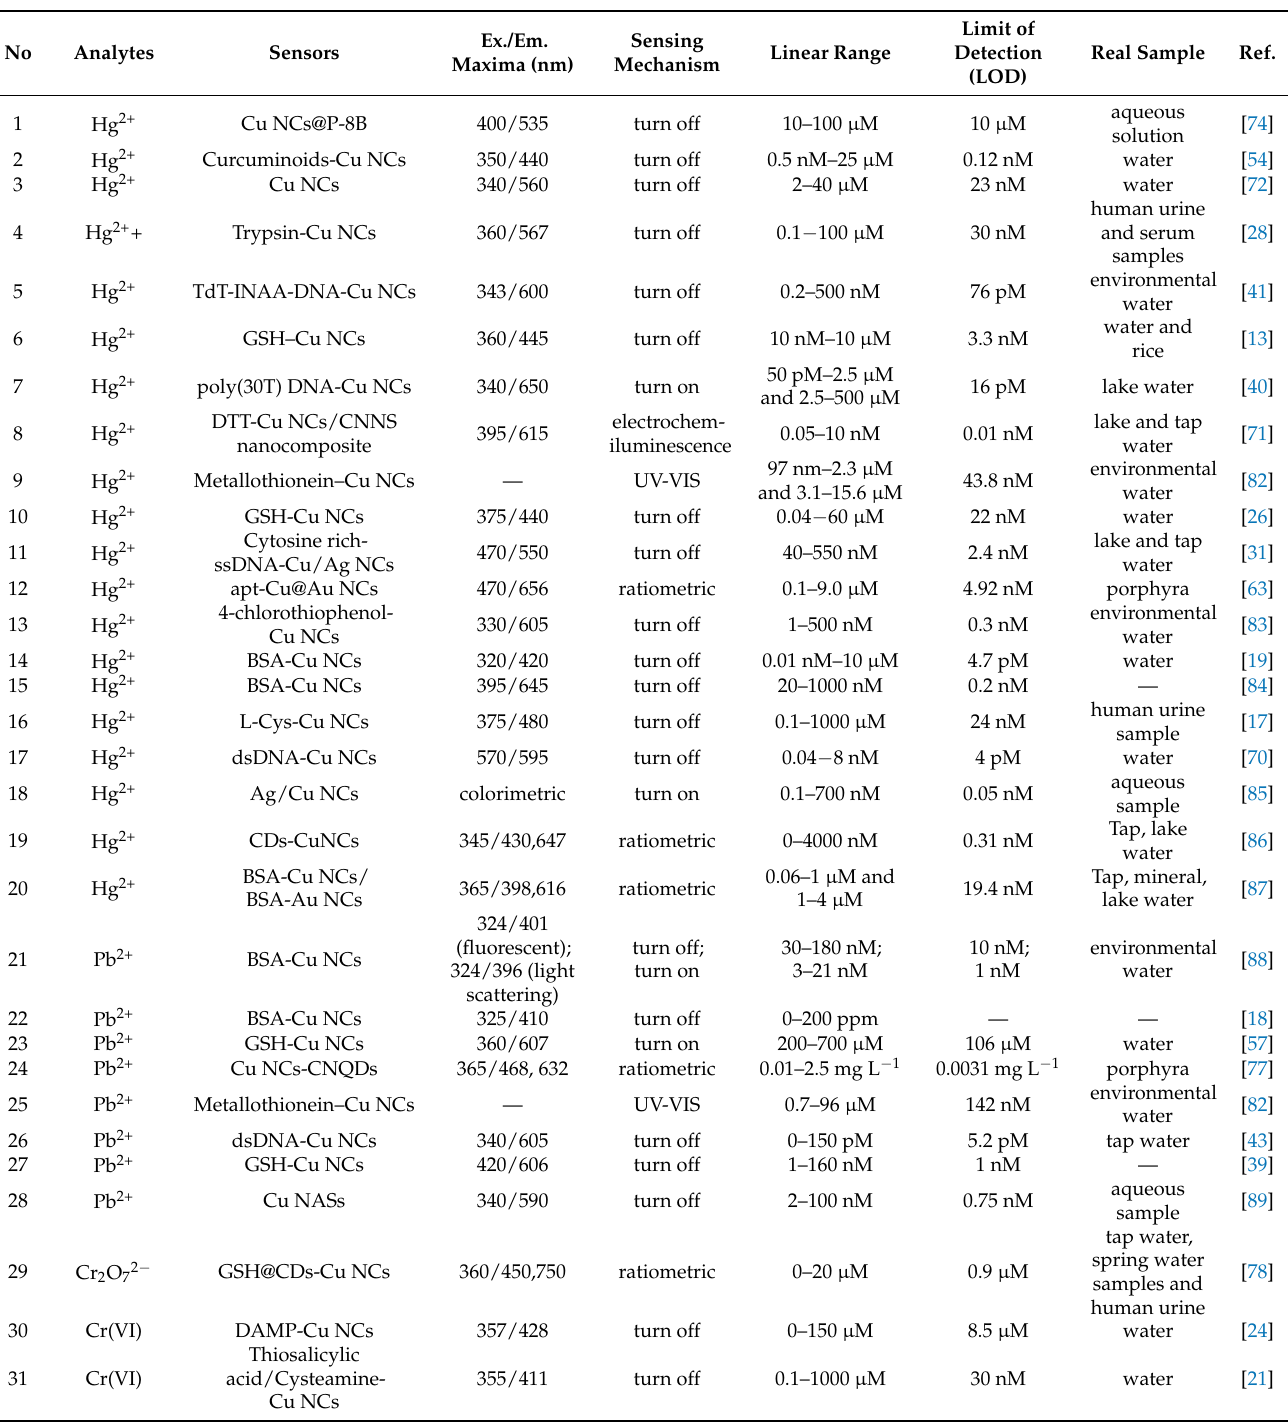
Table 2. List of fluorescent probes based on Cu NCs for heavy metal